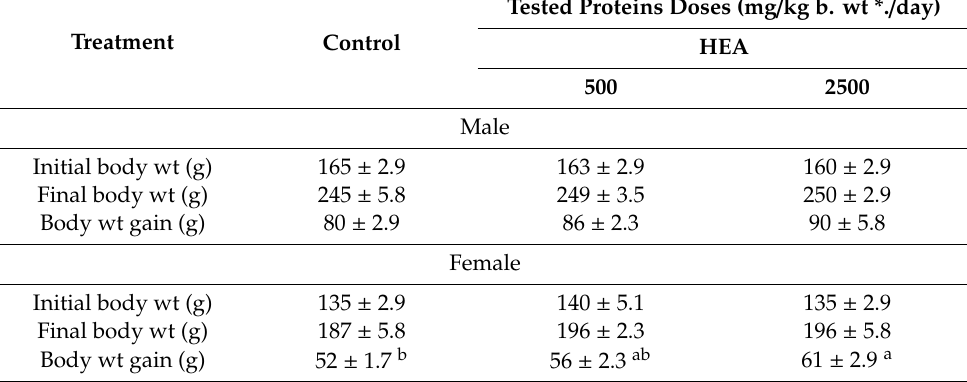
Table 4. Body weight gain (g) of male and female albino rats treated orally with daily hydrolyzed egg albumin (HEA) for 28